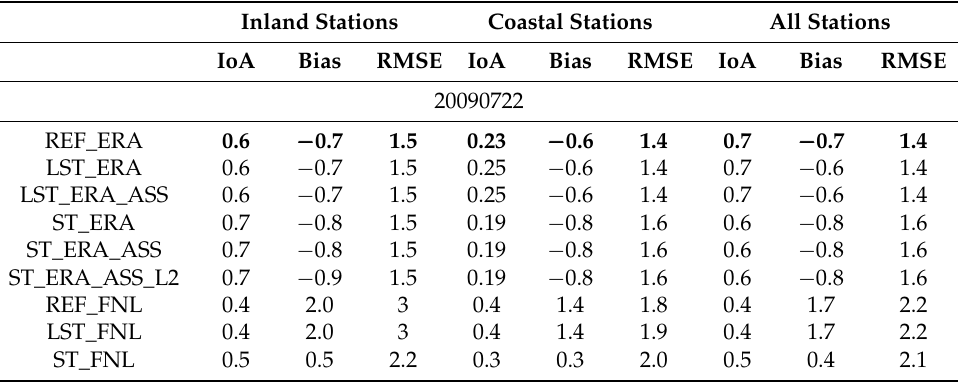
Figure 6. Same as Figure 4, but on 24 July 2009. Table 5. Same as Table 4, but considering the minimum